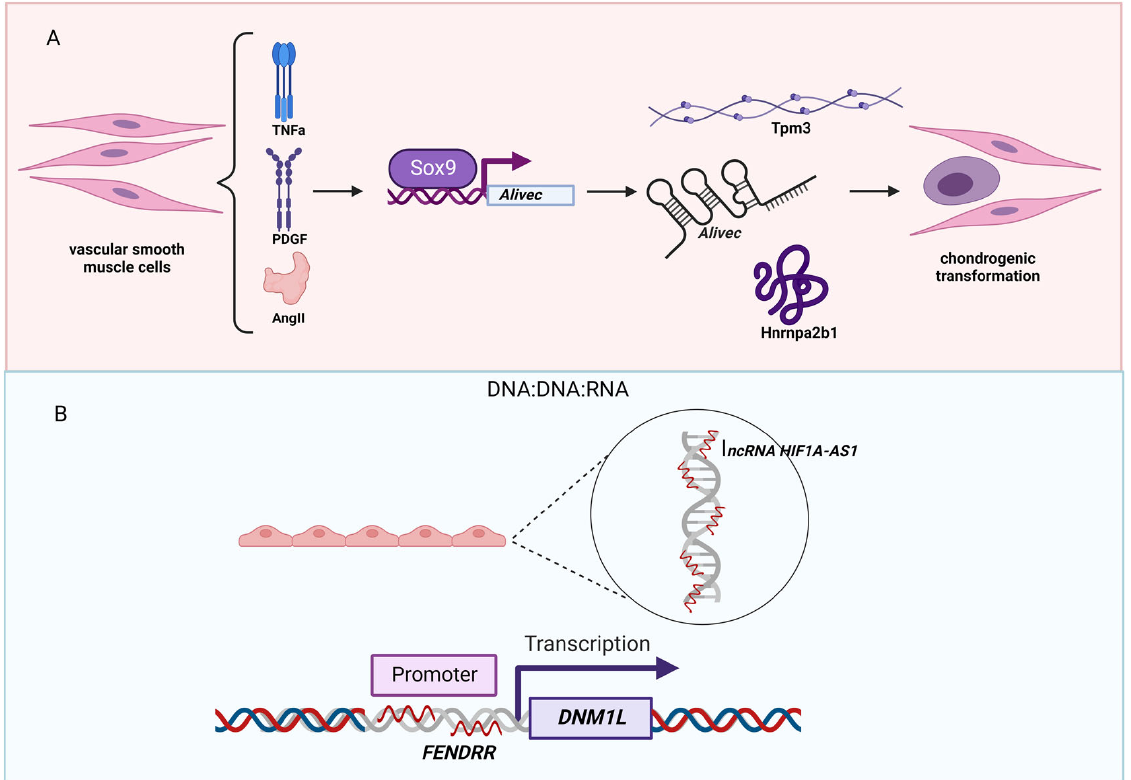
Figure 4. LncRNAs associated with hypertension. ( A ) In vascular smooth muscle cells, the expression of the lncRNA Alivec is induced by the growth factors AngII, TNFa, and PDGF via the transcription factor Sox9. Mechanistically, Alivec binds to tropomyosin 3 and Hnrnpa2b1 and regulates chondrogenic transformation of smooth muscles observed in vascular dysfunction and hypertension. ( B ) A mechanism by which lncRNAs implement a regulatory function through the DNA:DNA:RNA triplex formation. In human endothelial cells, the lncRNA HIF1A-AS1 serves as an adapter for the repressive human silencing hub complex (HUSH). Another lncRNA, FENDRR , forms a triplex structure in the promotor region of dynamin 1 like ( DNM1L ). Figure created with BioRender.com (accessed on 9 December 2022).